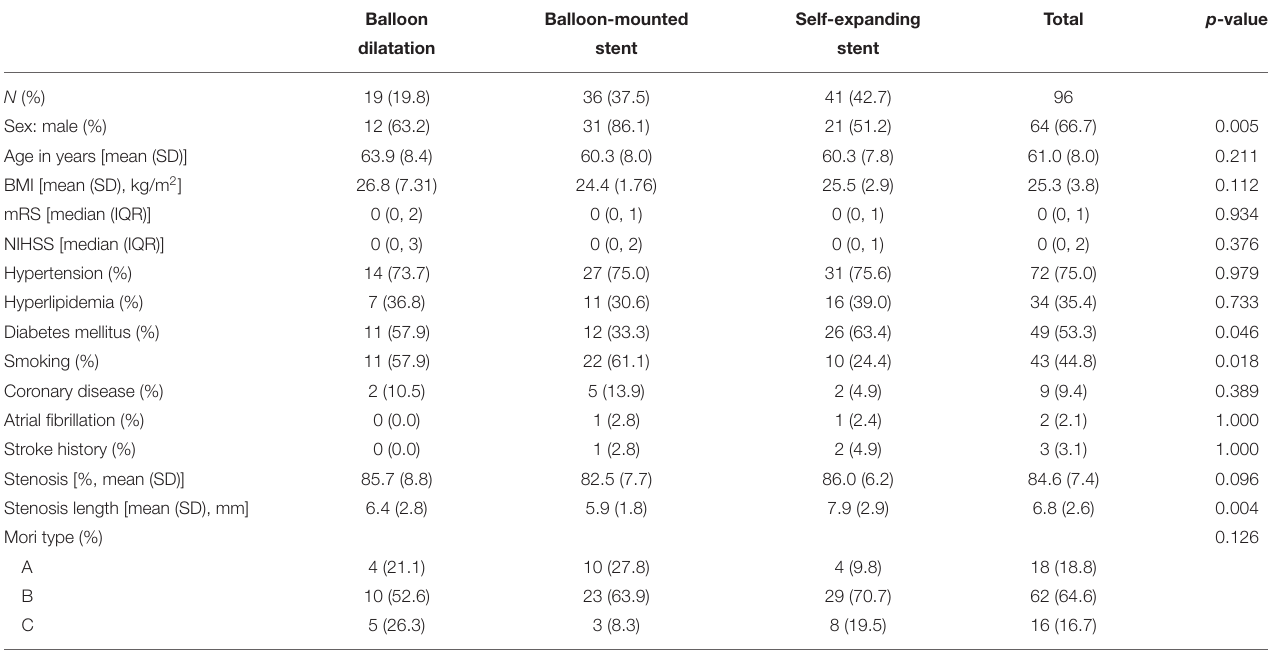
TABLE 1 | Baseline characteristics of patients receiving endovascular treatment in different groups. Balloon Balloon-mounted Self-expanding Total p -value